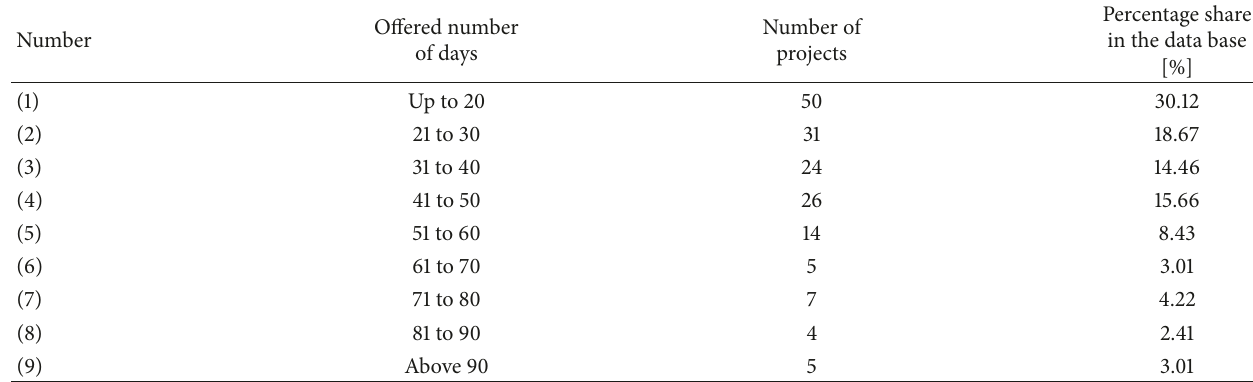
Table 2: Number of projects according to the offered number of days for